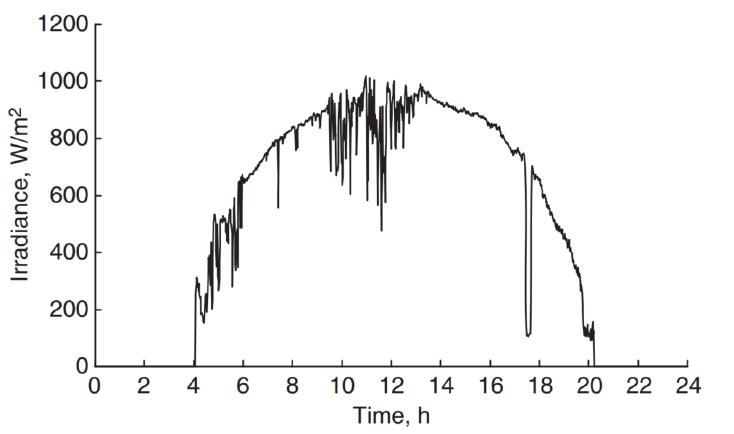
Figure 11. The impact of a moving cloud on the time-series of irradiance, reproduced with permission from